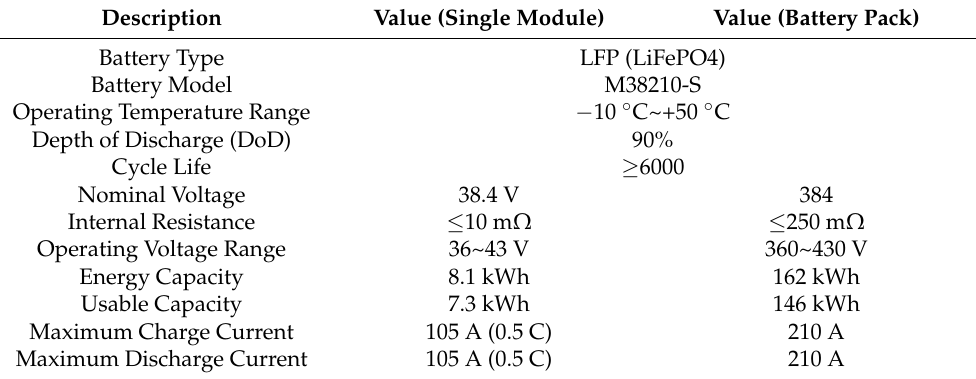
Table 3. Characteristics of the modelled battery module from